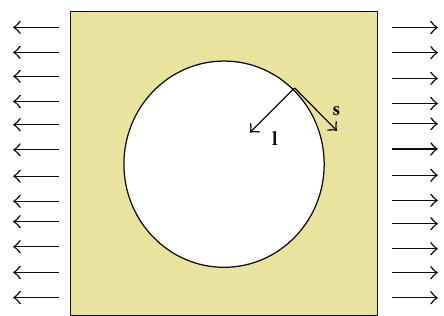
Figure 5: Unilateral tension of domain Ω 1